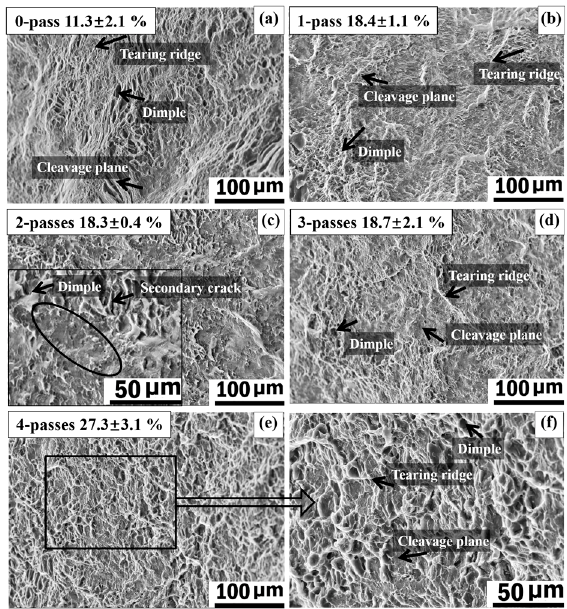
Figure 10. SEM fractography of ( a ) 0-pass (as-extruded); ( b ) 1-pass; ( c ) 2-pass; ( d ) 3-pass; ( e ) 4-pass ECAPed Mg-1Y alloys; and ( f ) higher magnification of the rectangular selection of ( e ).